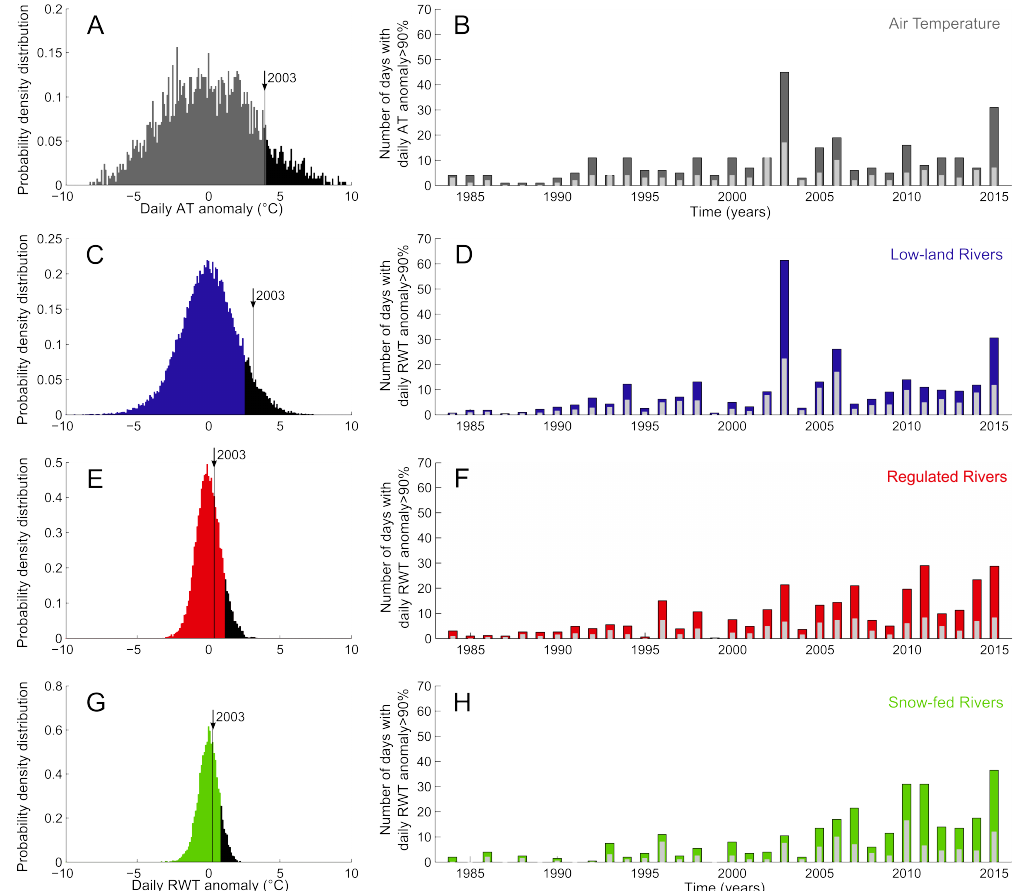
Figure 2. Distributions of daily anomalies during the summer period JJA, considering air temperature ( A ) and water temperature for low-land ( C ), regulated ( E ) and snow-fed ( G ) rivers. Shaded areas show the top 90th percentile in the distribution and arrows indicate the averaged anomalies for the strong heatwave in 2003. The number of days exceeding 90% is shown in the right column ( B , D , F , H ) for the period 1984–2015, with inset bars indicating the number of consecutive